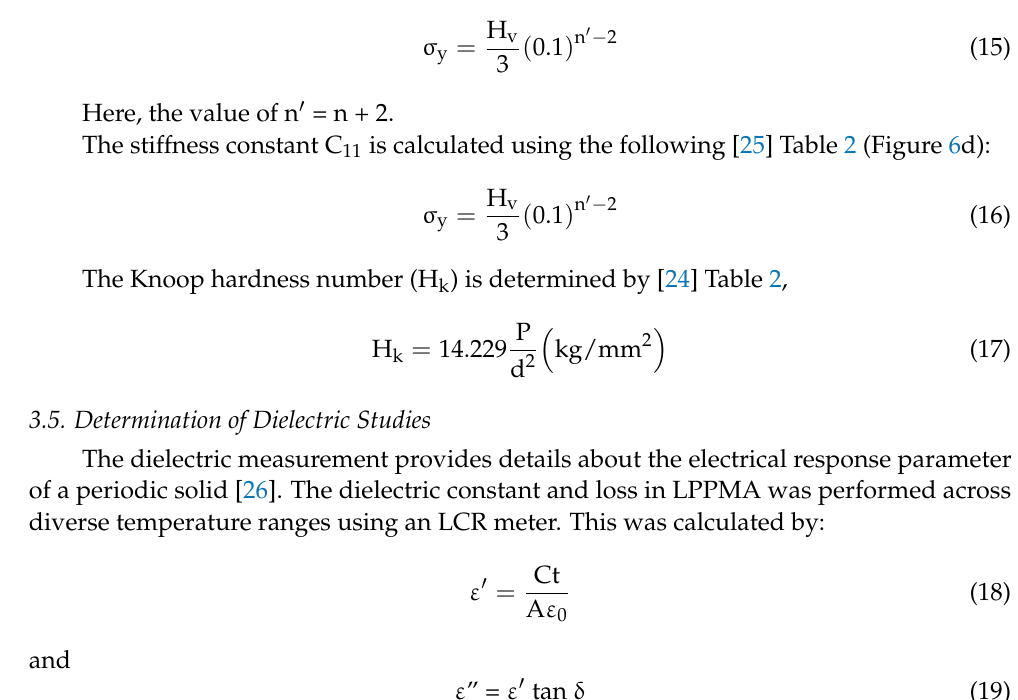
Table 2. Mechanical parameters of LPPMA.